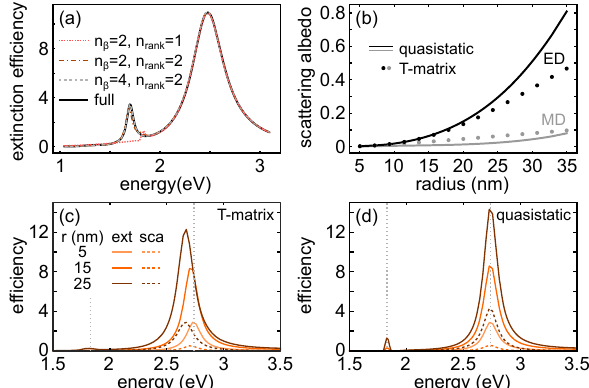
( 𝜖 ⊥ , 𝜖 ) [57] are third order ∥ 3